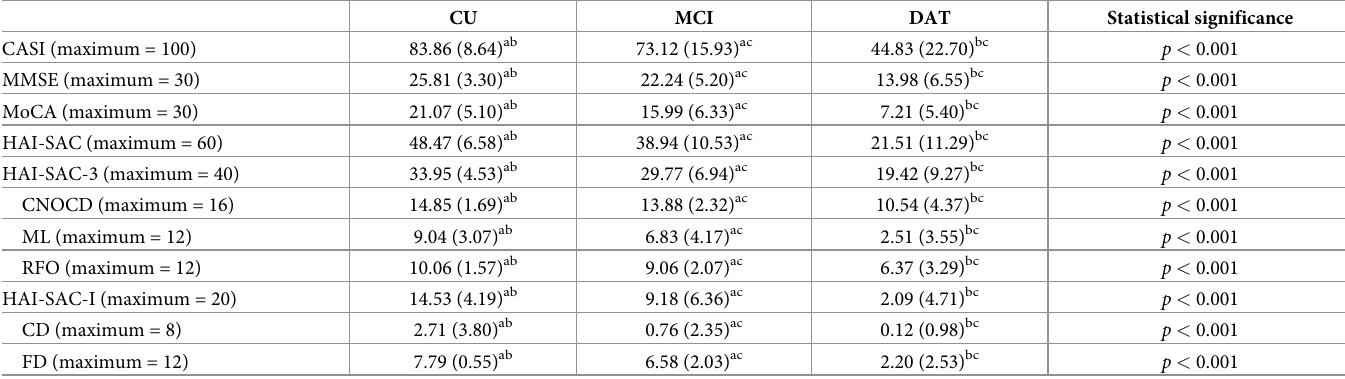
Table 3. Performance on neuropsychological tests across groups.